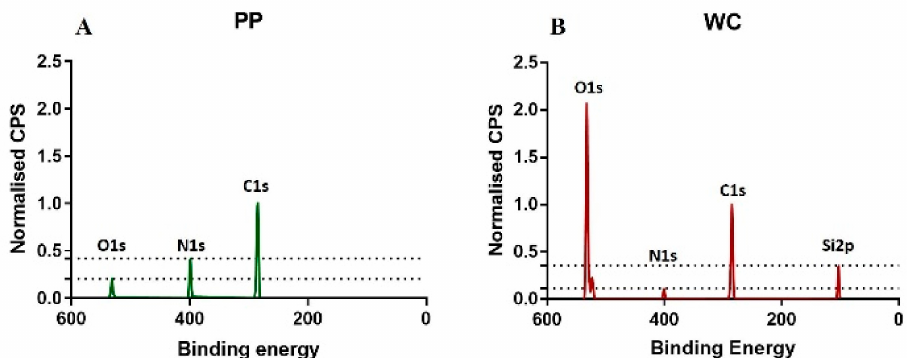
Figure 1. XPS survey spectrum of PP ( A ) and WC ( B ) coatings on glass substrate samples shown as counts per second (CPS) vs bind-ing energy. The background was subtracted, and each graph was normalized to